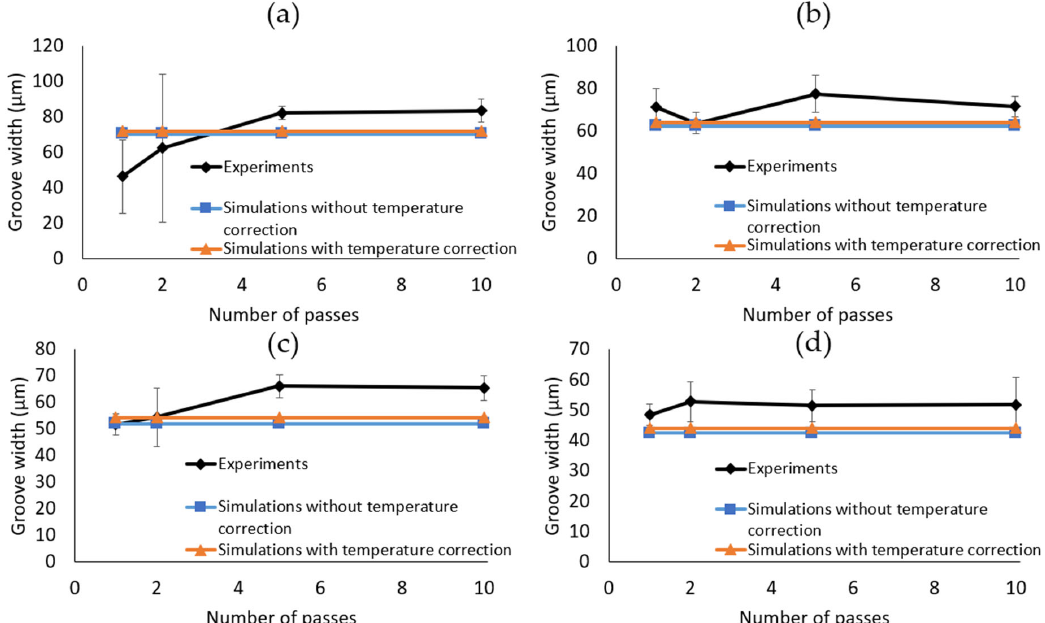
(cid:3404) (cid:3295)(cid:3283)